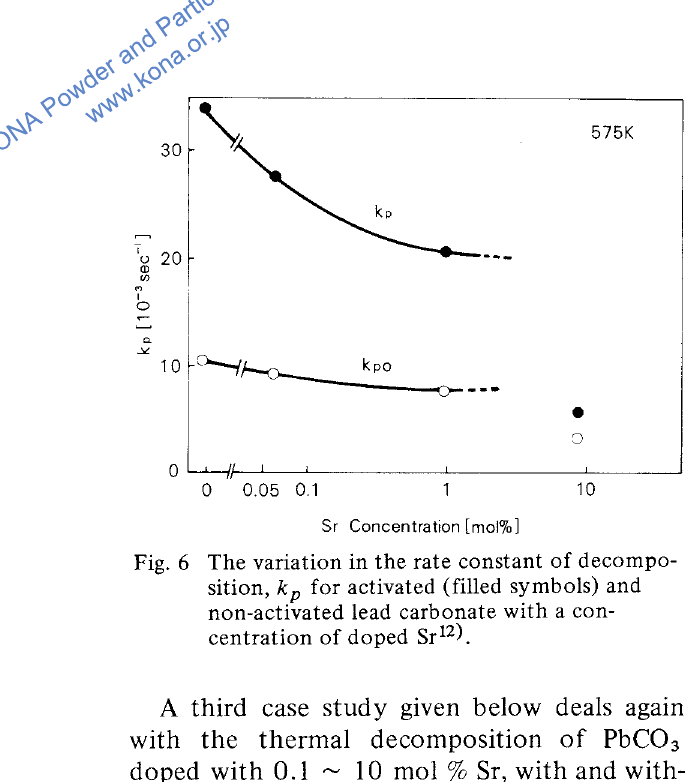
Fig. 6 The variation in the rate constant of decompo sition, k P for activated (filled symbols) and non-activated lead carbonate with a con centration of doped Sr 12).